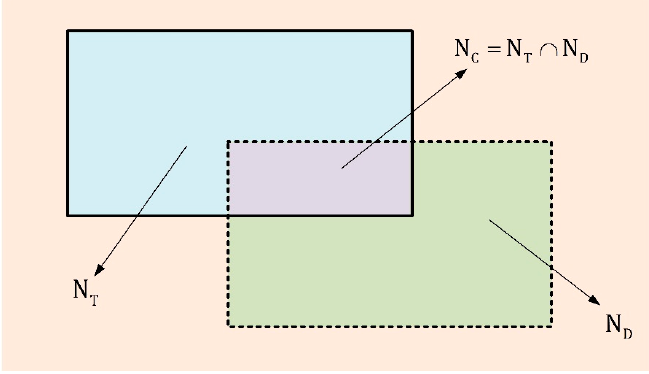
Figure 11. Schematic diagram of the parameters used for the measurement of detection accuracy.